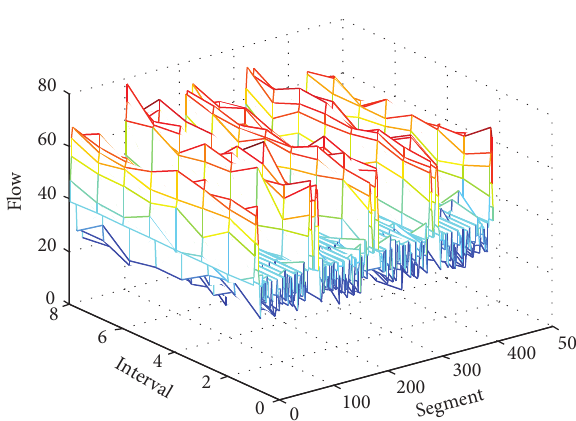
Figure 3: Flow on each segment per interval when demand is